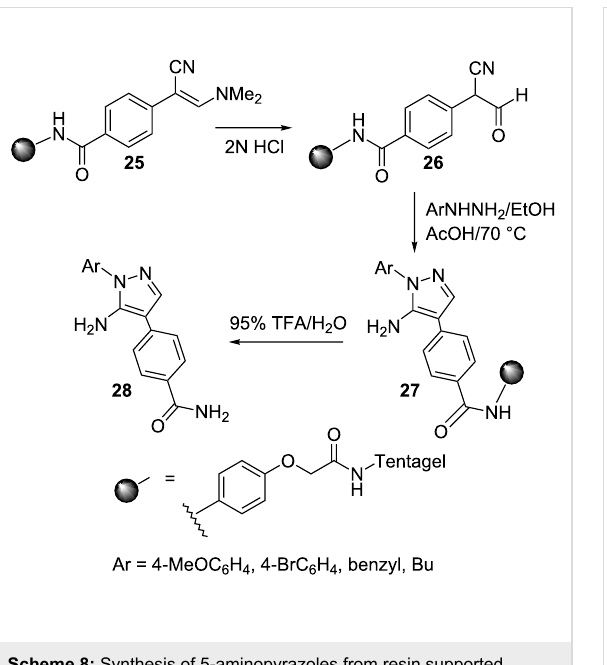
Scheme 8: Synthesis of 5-aminopyrazoles from resin supported enamine nitrile 25 as the starting material.